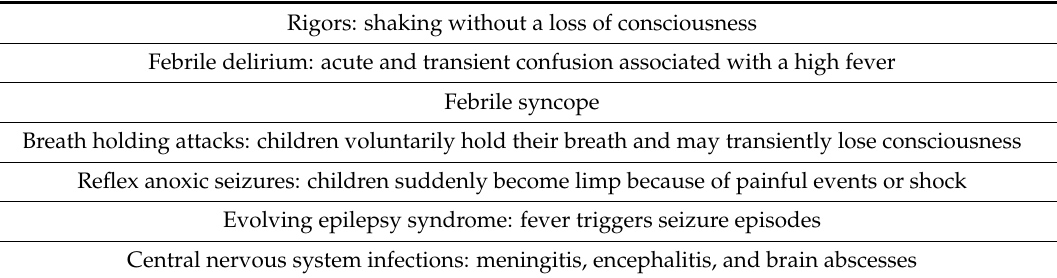
Table 2. Differential diagnosis of febrile seizures